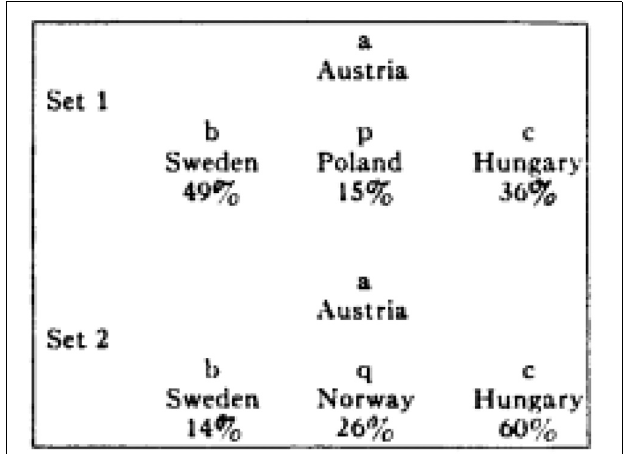
FIGURE 1 | Stimuli used in Experiment 1 (Tversky, 1977).